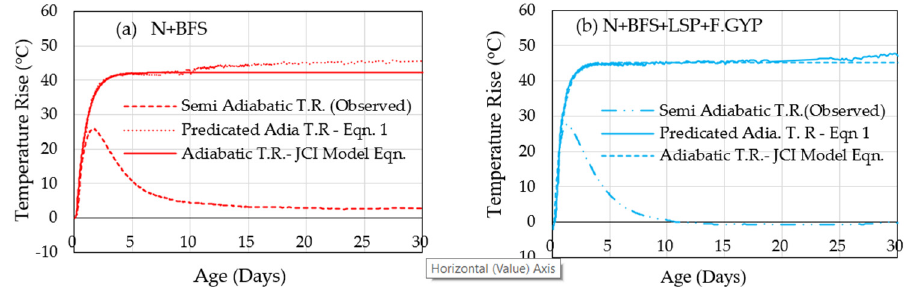
Figure 9. Observed semi adiabatic and predicated adiabatic temperature rise. Table 7. Adiabatic temperature rise properties of